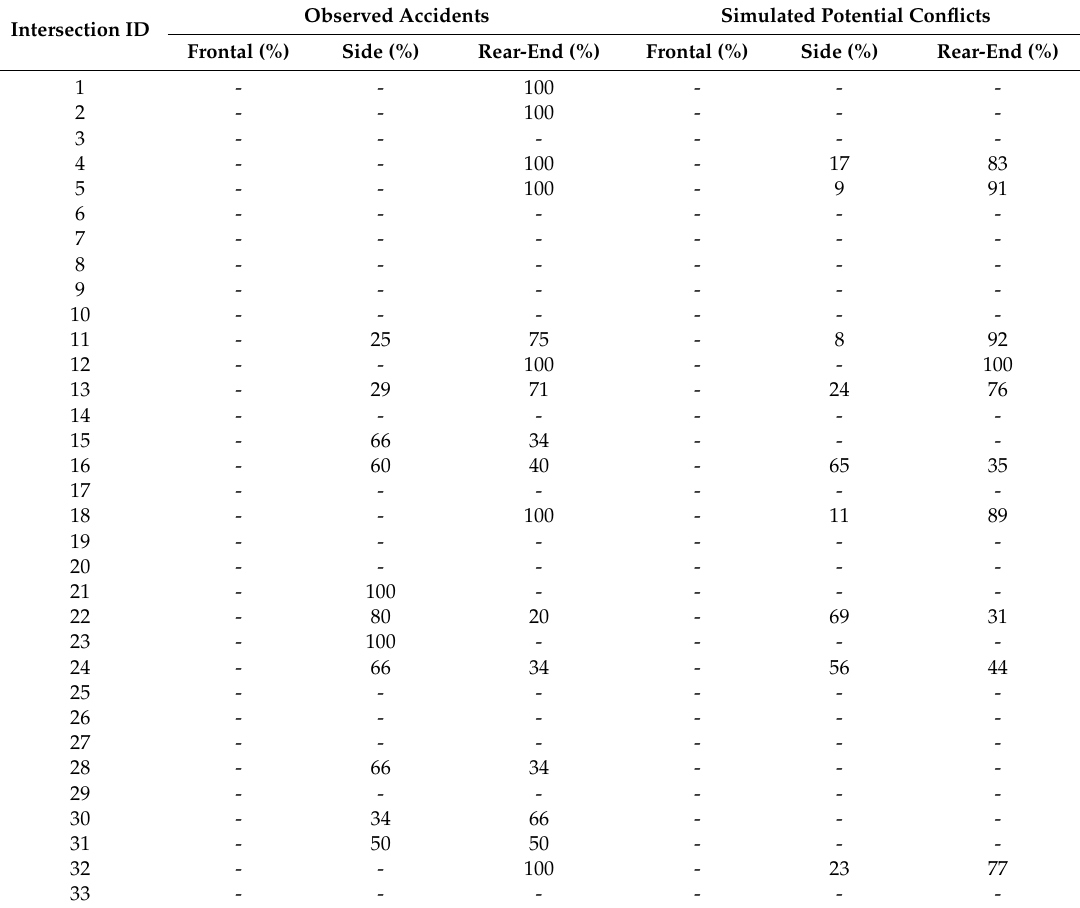
Table 2. Simulated potential conflicts and observed accidents grouped by